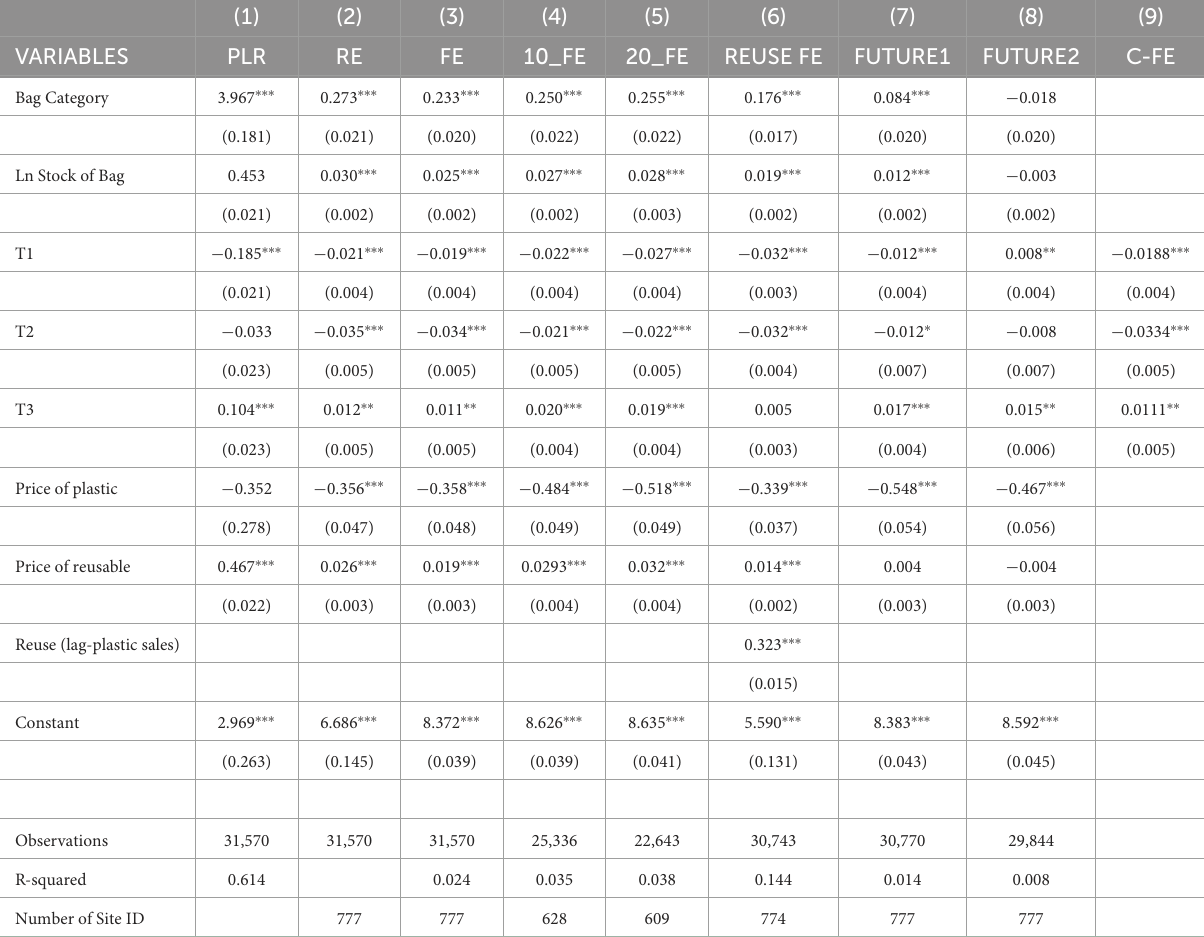
TABLE 2 Regression results for plastic bags